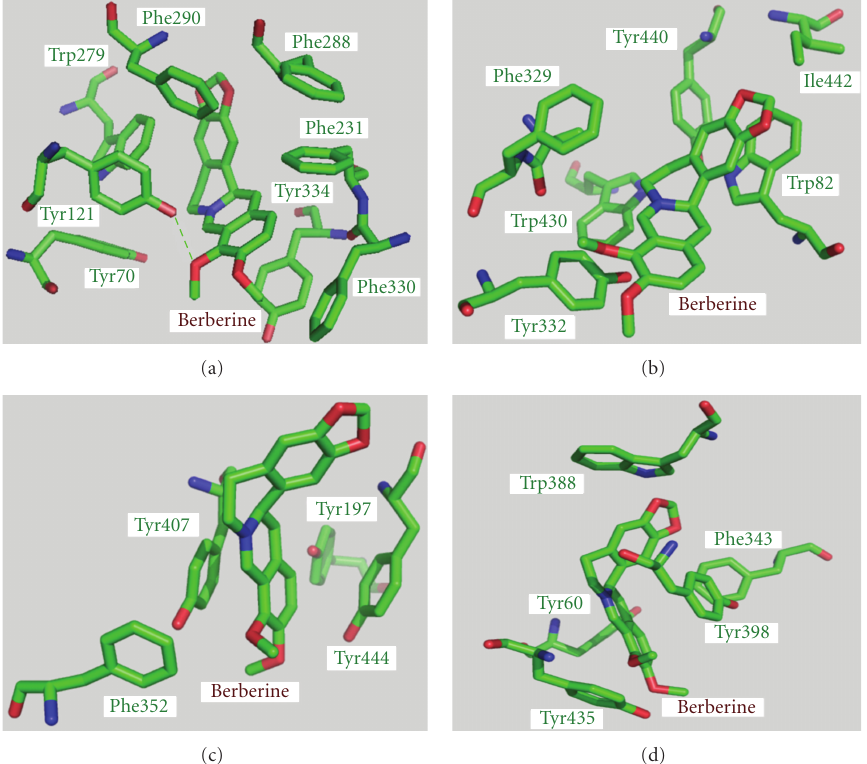
Figure 2: Close-up views of binding modes of berberine in AChE (a), BChE (b), MAO-A (c), and MAO-B (d). The hydrogen bond is marked in green dotted